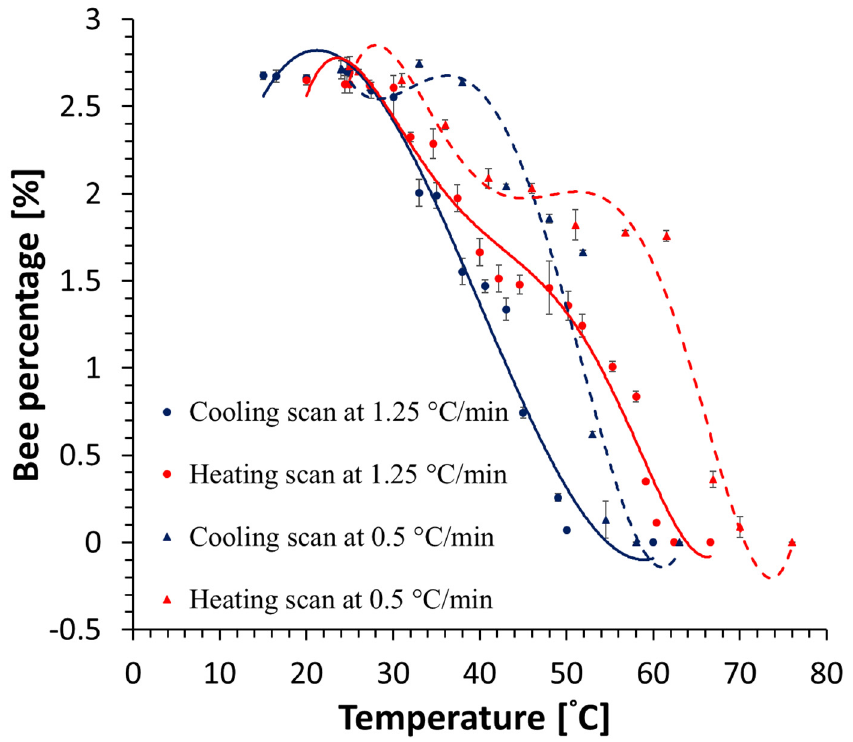
Figure 6. Evolution of CLSM bee structures during heating and cooling scans. Markers are experi- mental data points, whereas full and dashed lines are polynomial guides.